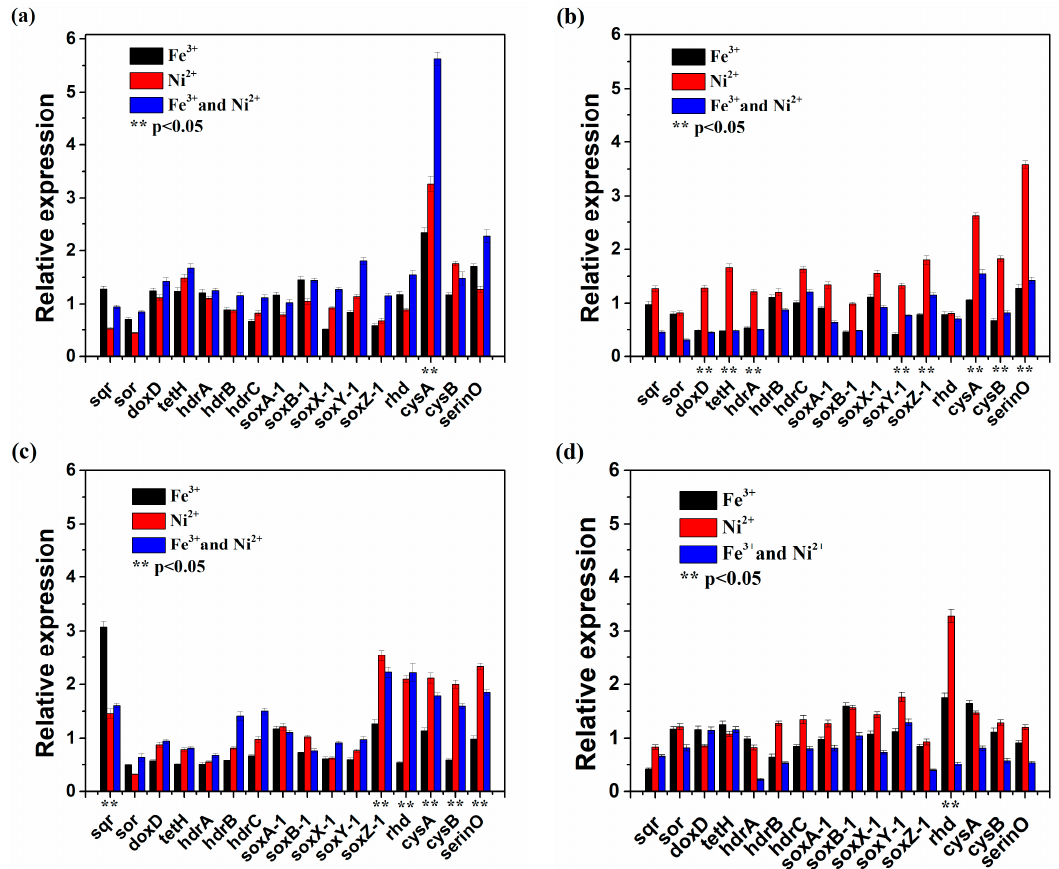
Figure 5. The expression of sulfur metabolism-related genes in At. thiooxidans A01 in 10th min ( a ), 30th min ( b ), 60th min ( c ), 120th min ( d ) after single or joint Ni 2+ and Fe 3+ shock.